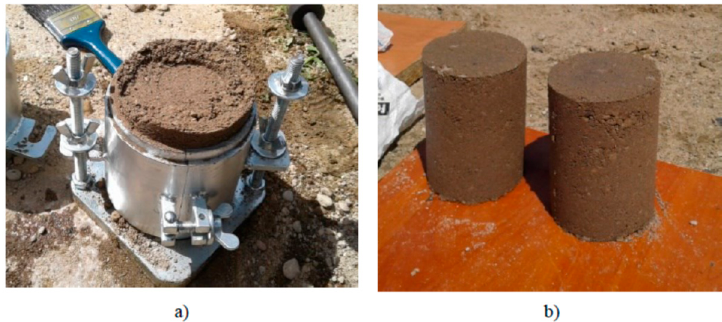
Figure 6. Preparation of the samples made of fine aggregate with cement: cylindric form ( a ); samples ( b ).